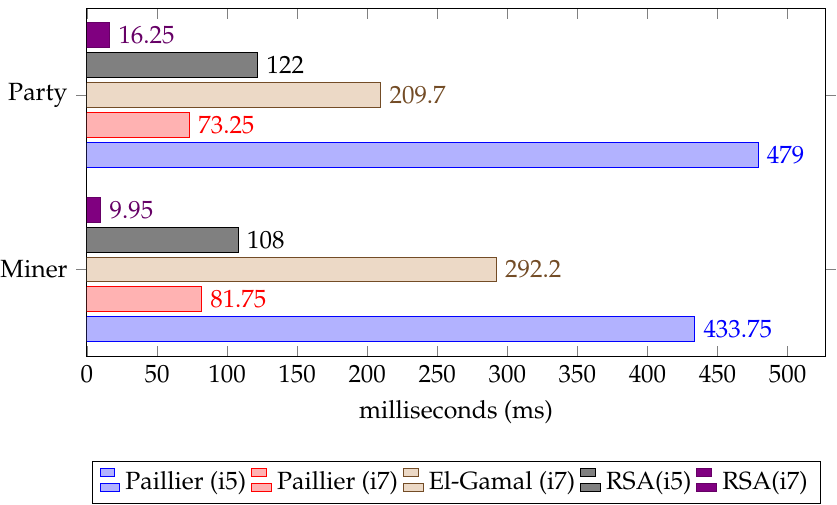
Figure 7. Comparison of key establishment